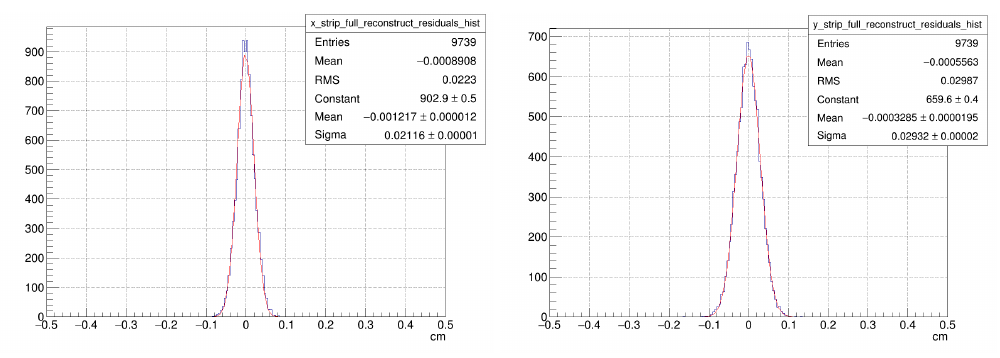
Figure 7. (Left) Residual error of X-reconstructed coordinate; (right) residual error of Y-reconstructed coordi- nate. The results are presented for particle tracks with inclination angle from 0 to 15 degrees from beam